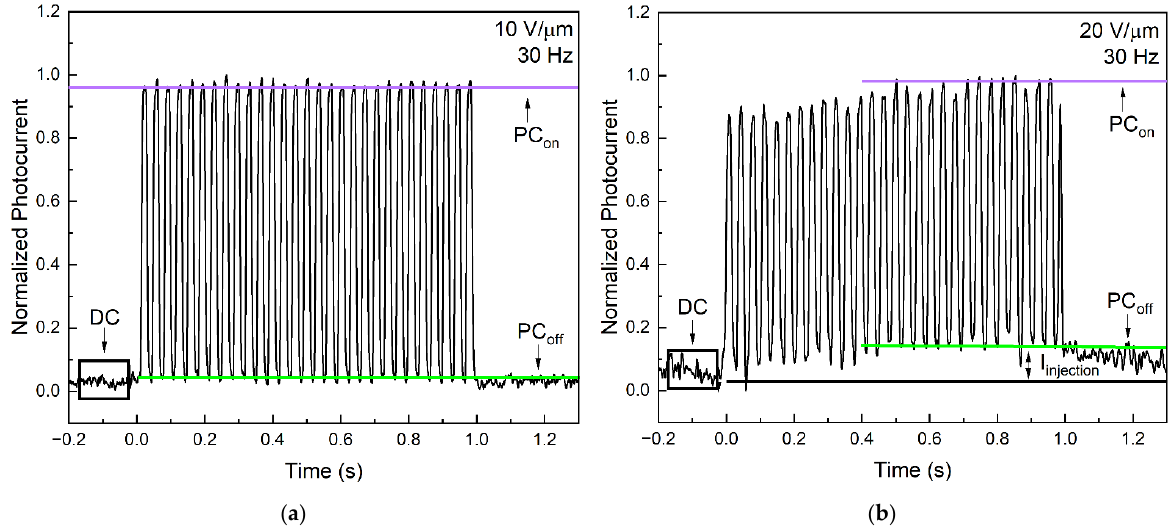
Figure 6. Response of PI/a-PbO/poly-PbO detector prototype to modulated 30 Hz X-ray irradiation at ( a ) 10 V/µm and ( b ) 20 V/µm, showing the build-up of a photocurrent at high fields.